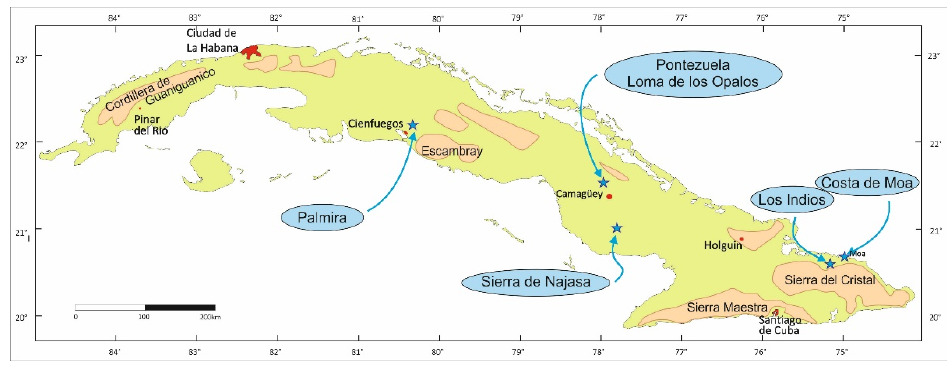
Figure 1. A geomorphological map of Cuba showing occurrences of different SiO 2 mineralization. Agates were sporadically found in Upper Cretaceous rocks overlaying ophiolites of the Camagüey fault zone NE of Camagüey. In addition, chalcedony, jasper and silicified corals are reported from the Rio Yumuri region near Matanzas [2]. In the eastern part of Cuba, silica mineralization occurs in particular in the surrounding area of Moa. Jasper was found in altered serpentinites of the Costa de Moa region, whereas agates/chalcedony occur in altered volcanic rocks in the region of El Picado, W of Moa as well as near Baracoa on the river Toa, E of Moa (Figure 1).